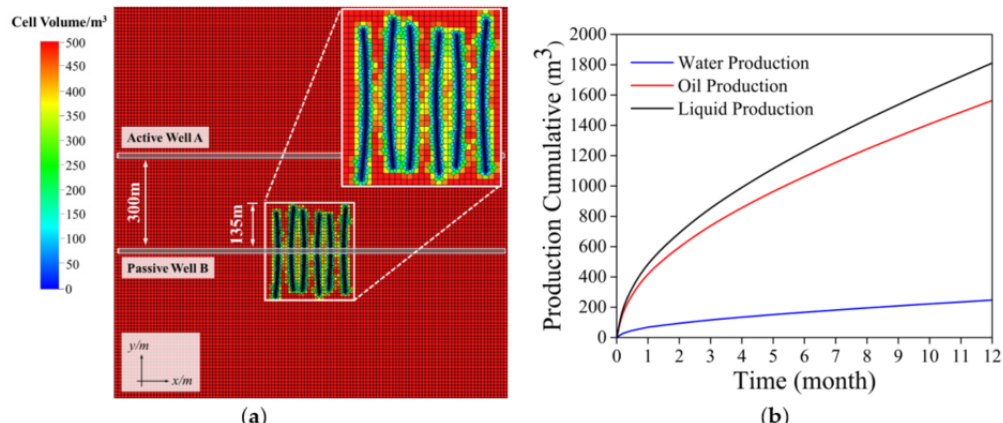
sponse, the horizontal in-situ stress in the drainage area decreased in parallel with the